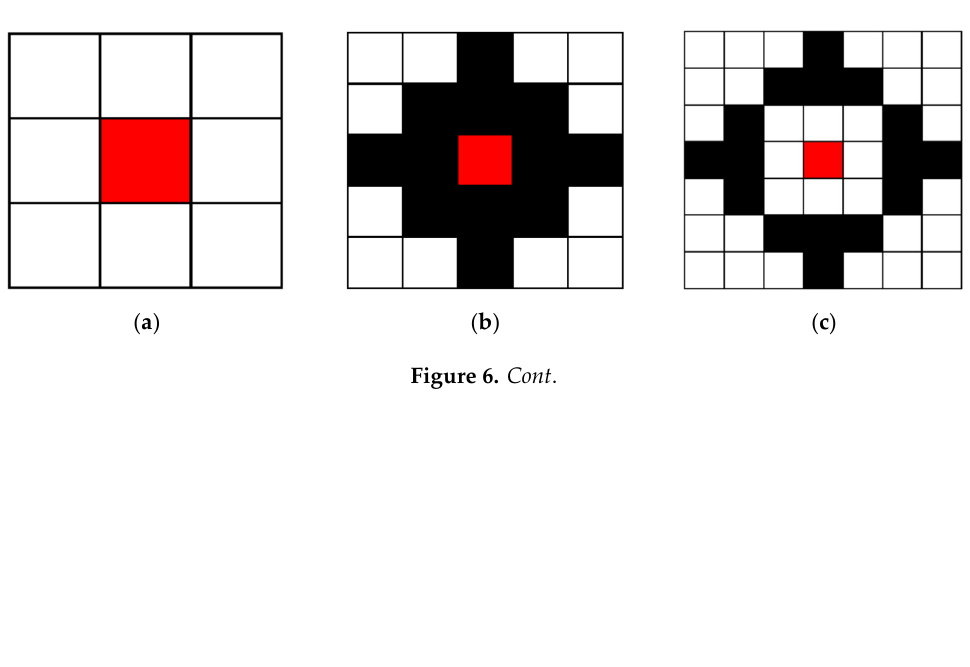
Figure 5. The order of pixel calculation (with a 7 × 7 window size).